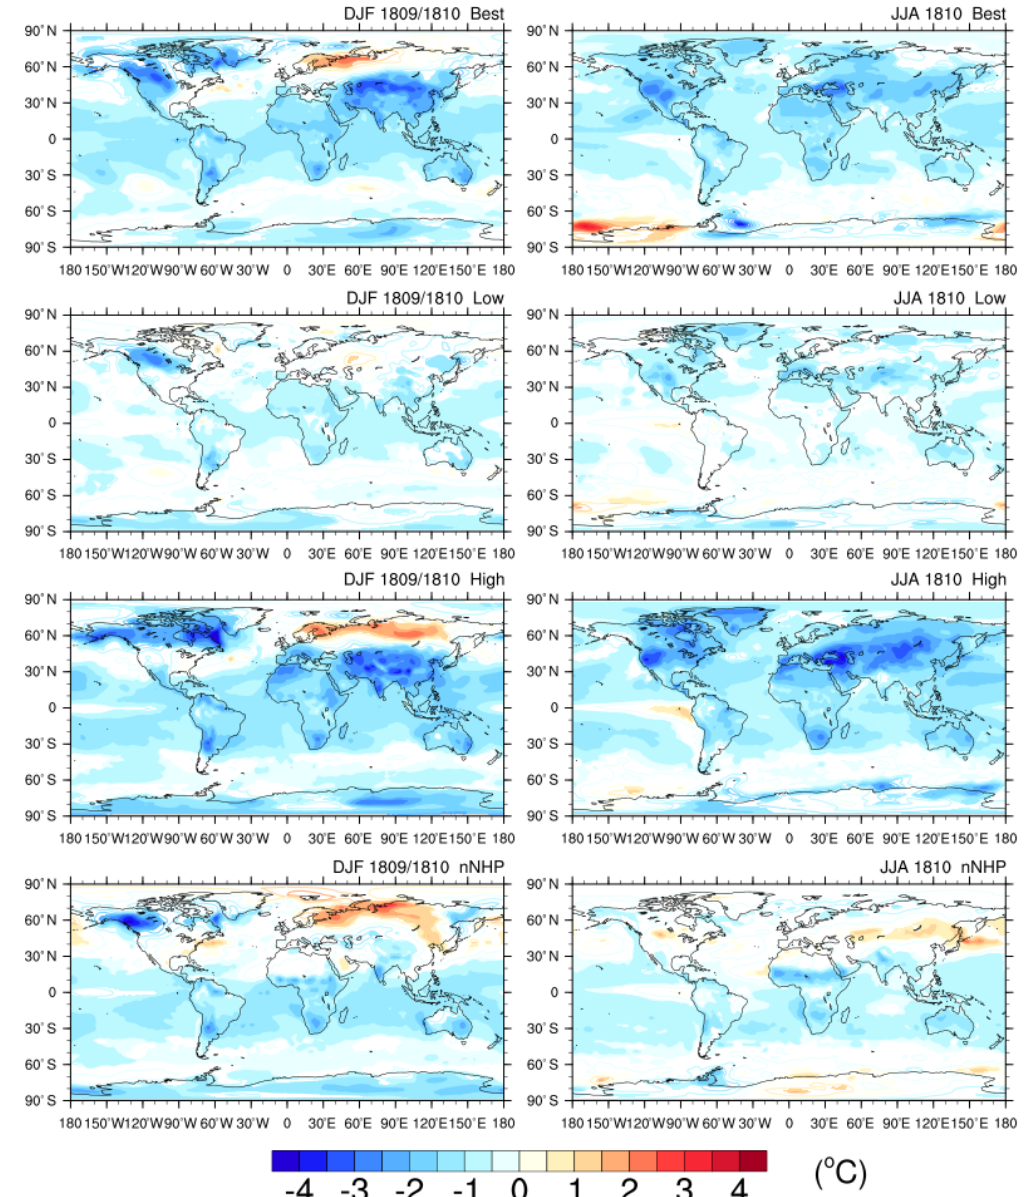
Figure 5. Simulated ensemble-mean near-surface air temperature anomalies for the first winter (1809/1810) and the second summer (1810) after the 1809 eruption for the four different MPI-ESM simulations. Shaded regions are significant at the 95% confidence level according to a t test. Anomalies are calculated with respect to the period